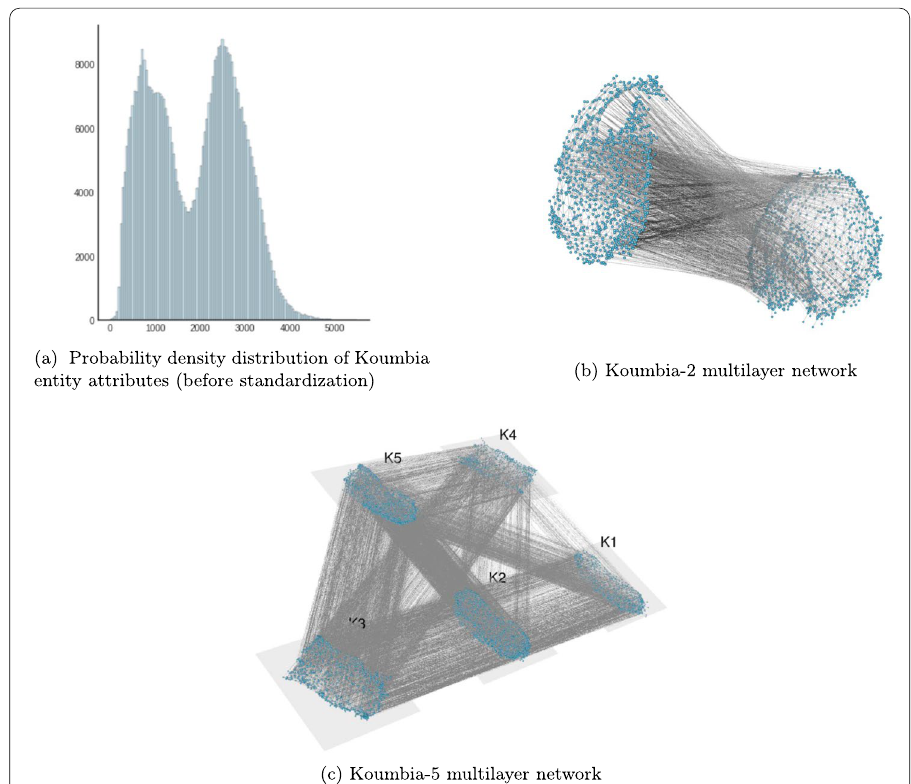
Fig. 5 Feature distribution of Koumbia entity attributes (obtained by linearizing the input feature matrix) and visual representation of Koumbia-2 and Koumbia-5 with inter-layer and intra-layer